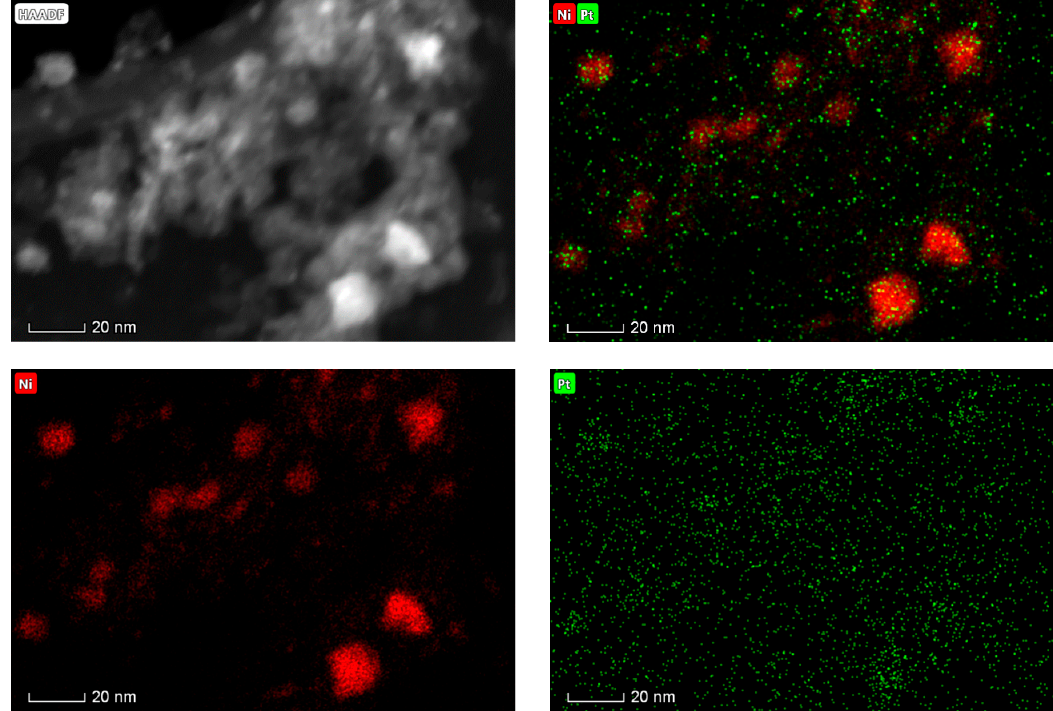
Figure A2. High-angle annular dark-field (HAADF) scanning transmission electron micrograph ( top left ) of a region within the 20% Ni-0.5% Pt/Al 2 O 3 catalyst and the corresponding elemental maps of both Ni and Pt ( top right ), Ni only ( bottom left ), and Pt only ( bottom right ).